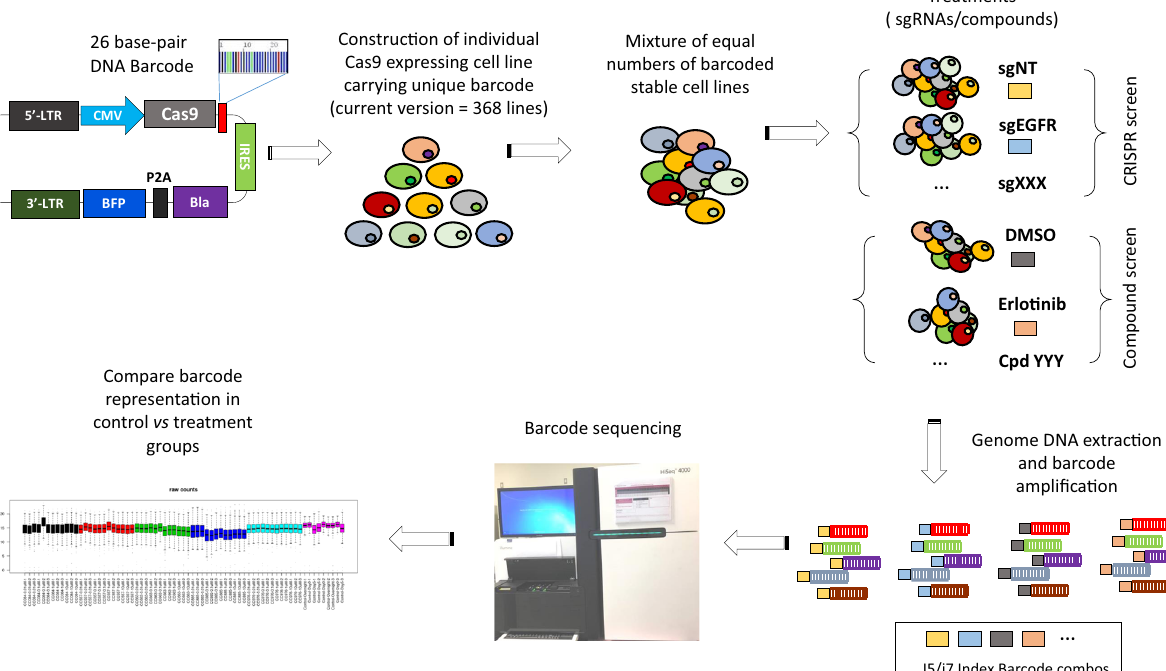
Fig. 1 Overview of BMS-PRISM platform. Solid tumor cell lines were individually infected with Cas9 and 26-bp barcode and tested for CRISPR editing ef fi ciency before archived into BMS-PRISM library. These engineered cell lines were then subpooled and banked according to cancer indications for convenient handling. A full or focused collection of cell lines can be used for the compound as well as CRISPR/Cas9 knockout screening to evaluate drug response or gene essentiality in a single run. Relative cell line abundance after various treatments can be determined by PCR ampli fi cation of barcodes and next-generation